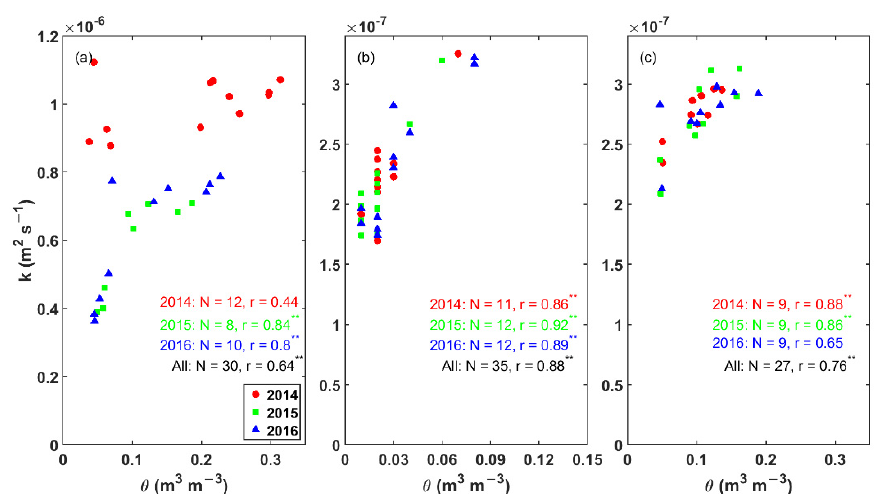
Figure 7. Same as Figure 6, but for the relationship between median k and θ on a monthly timescale. The number of months per year (N) and corresponding correlation coefficients (r) are given. “**” indicates p -value < 0.01, and there is no label after r if r is not significant ( p -value > 0.05). The data for a month are deleted when the number of days is less than 15.